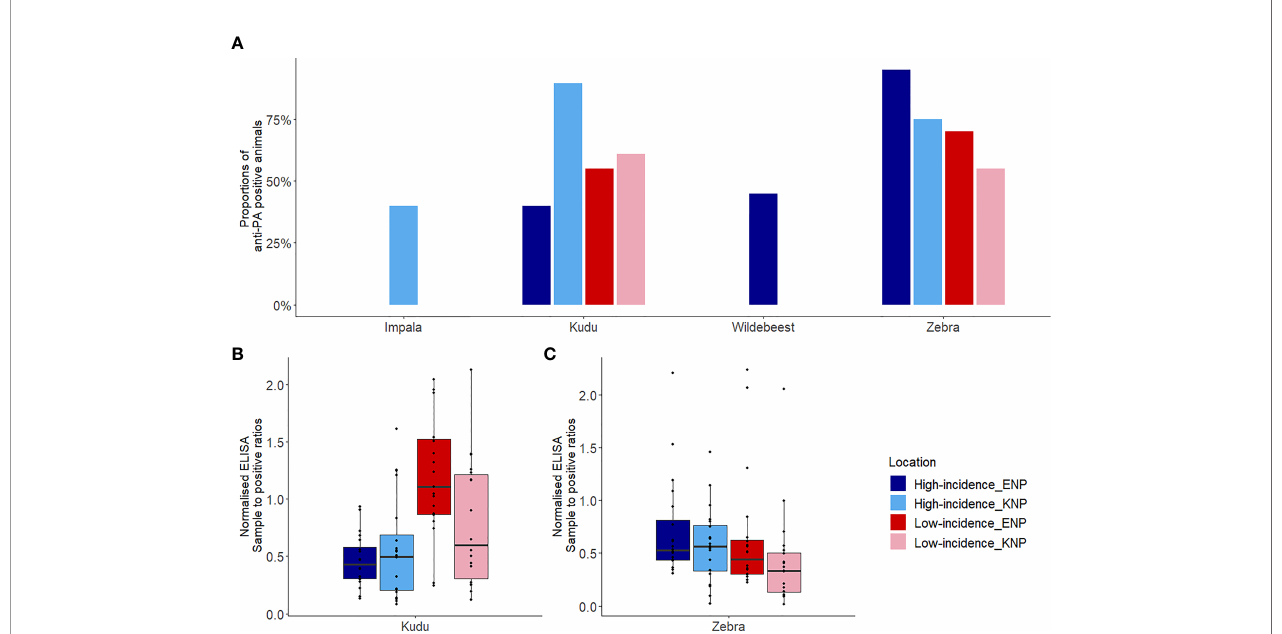
FIGURE 4 | Host exposures to Bacillus anthracis assessed based on anti-protective antigen (PA) antibody titres. (A) The proportion of each host species that was seropositive for anti-PA antibodies, as determined using enzyme-linked immunosorbent assay (ELISA), by area. (B, C) Box plots showing sample to positive (SP) ratios for antibodies against PA for (B) kudu ( Tragelaphus strepsiceros ) in each park and area, and (C) zebra ( Equus quagga ) in each park and area. Kudu and zebra were sampled from high incidence and low incidence areas of Kruger National Park (KNP) in South Africa and Etosha National Park (ENP) in Namibia, while impala ( Aepyceros melampus ), and wildebeest ( Connochaetes taurinus ) were sampled from only the high incidence area of KNP and ENP, respectively. Box plots (B, C) were separated to avoid comparison between species as the technique utilized is species-speci fi c. The locations of high and low incidence areas in each park are shown in Figure 1 .